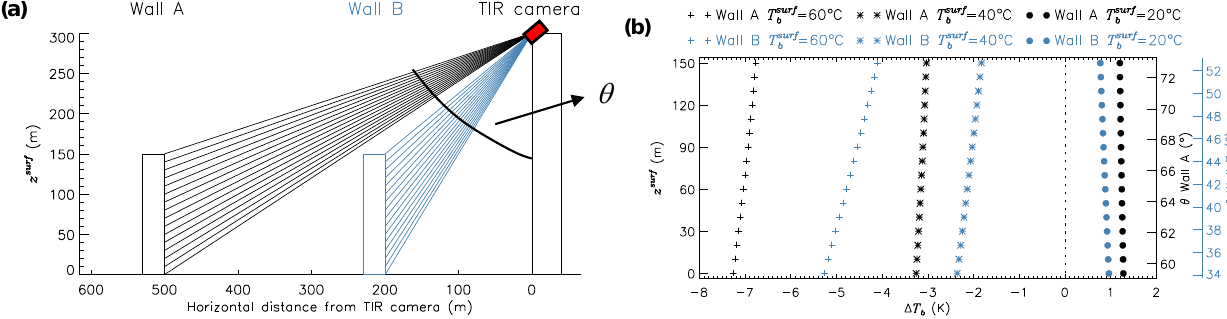
Fig. 1. (a) Scheme of the fictitious experimental setup and line-of-sight (LOS) geometry in order to demonstrate atmospheric effects on oblique TIR imagery in urban areas, (b) vertical profiles of 1T b for wall A (black) and wall B (blue) as a function of wall height ( z surf ) and corresponding view zenith angle ( θ ) for wall temperatures T surf of 20 ◦ C, 40 ◦ C and 60 ◦ C respectively, uniform air temperature of 25 ◦ C b and relative humidity of